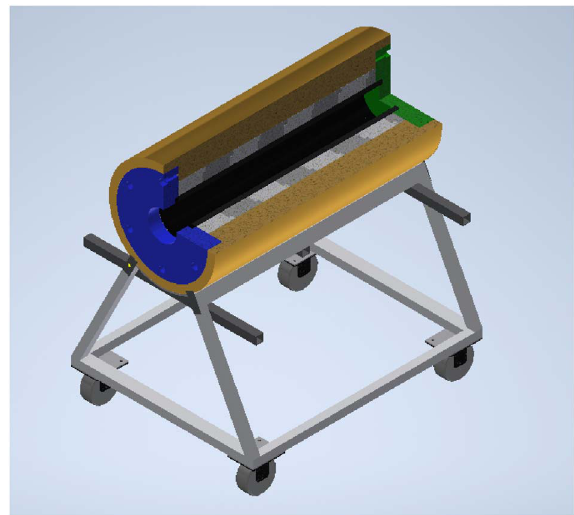
Fig. 1. A sketch of the standard mini-NM set-up. The re fl ector (yellow), moderator (black), front- and end-cap (blue and green), and lead rings (dark and light gray) are